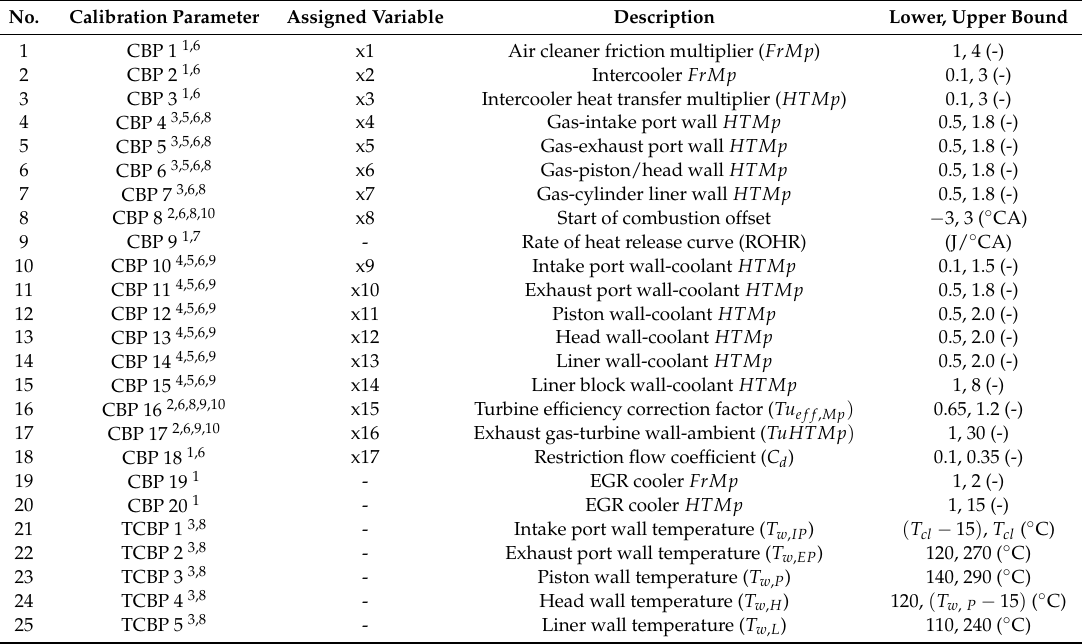
Table 1. Calibration parameters that are the subject of the ICESM calibration and the CBPs assigned variables x1, . . . , x17 used for the sensitivity